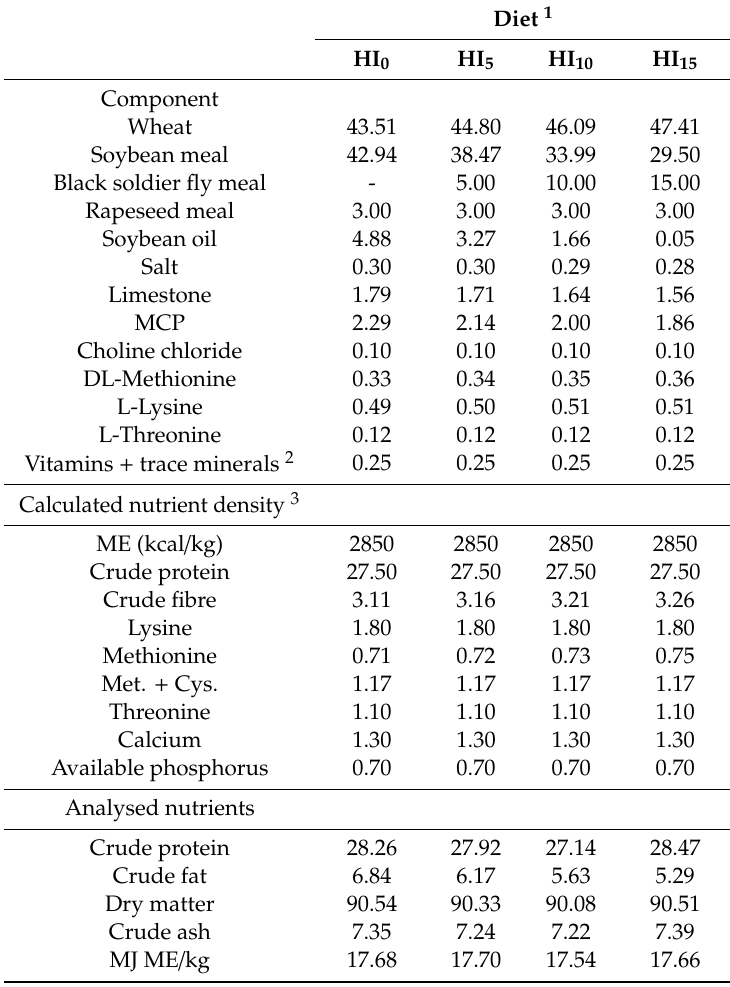
Table 2. Composition and nutrient density of the experimental diets, g /